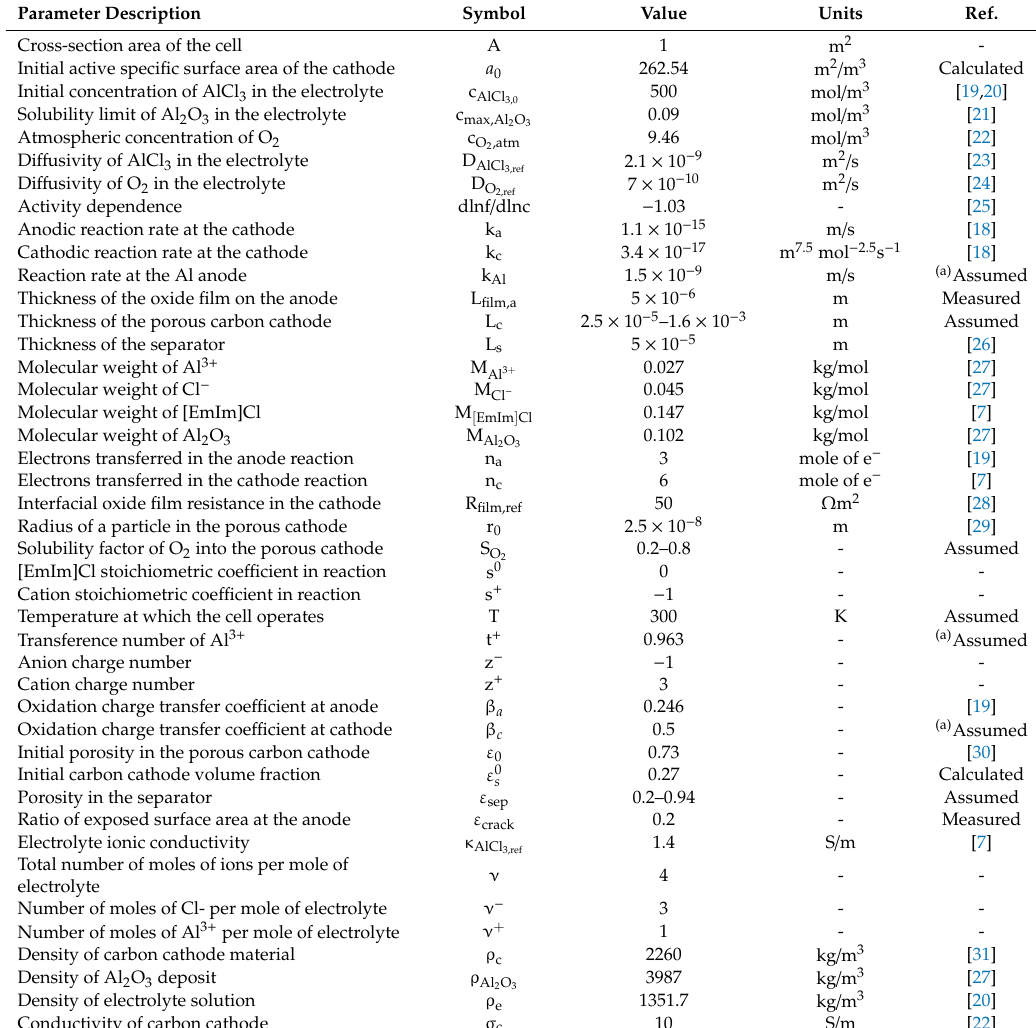
Table 1. Parameters used in the